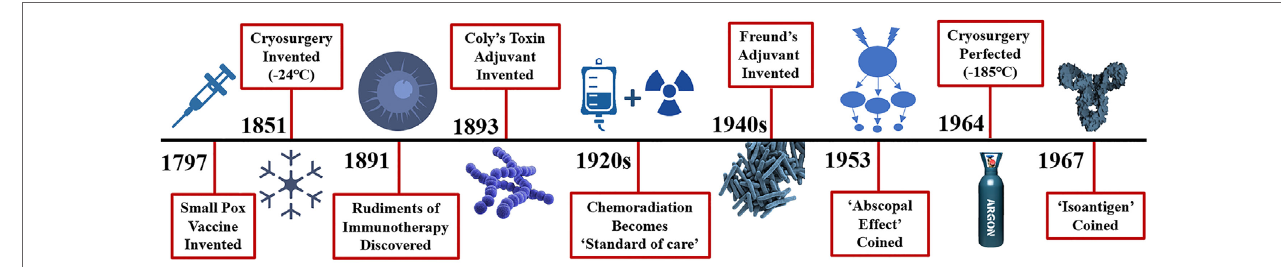
FiGURe 1 | Distant history of the rudiments of immunotherapy and cryosurgery. Efforts to stimulate or potentiate the immune response to diseases date back a millenium with the Greeks in fifth century BC attempting immunotherapy to combat the plague and ancient Chinese medical innovations to combat smallpox in 1000 AD. More recently, immune adjuvants such as Coly’s toxin in the 1890s and Freund’s adjuvant introduced in the 1940s yielded remarkable tumor regression. Surprisingly, injection of peri-tumor streptococcal infection results in a 39% reduction in cancer. Why further investigations of these adjuvants have fallen out of favor is not clear, however, new approaches in the effort to eradicate cancer took a turn to newer agents including chemotherapy, and radiation therapy, either in serially or parallel fashion along with hormonal adjuncts. The abscopal effect is defined as: the regression of distant metastases following treatment of the primary cancer. The first definitive observed abscopal effect was seen with radiation treatment of brain metastases in 1953. The abscopal effect was described in cryosurgery of an advance prostate cancer in 1963. In 1967 Yantorno et al. first identified and described how cryosurgical ablative intervention resulted in the production of antibodies directed at antigenic material linked to the frozen tissue itself. They reported that freezing male rabbit accessory tissue which was sensitized with glandular cellular components via injection led to the formation of circulating antibodies with a specified